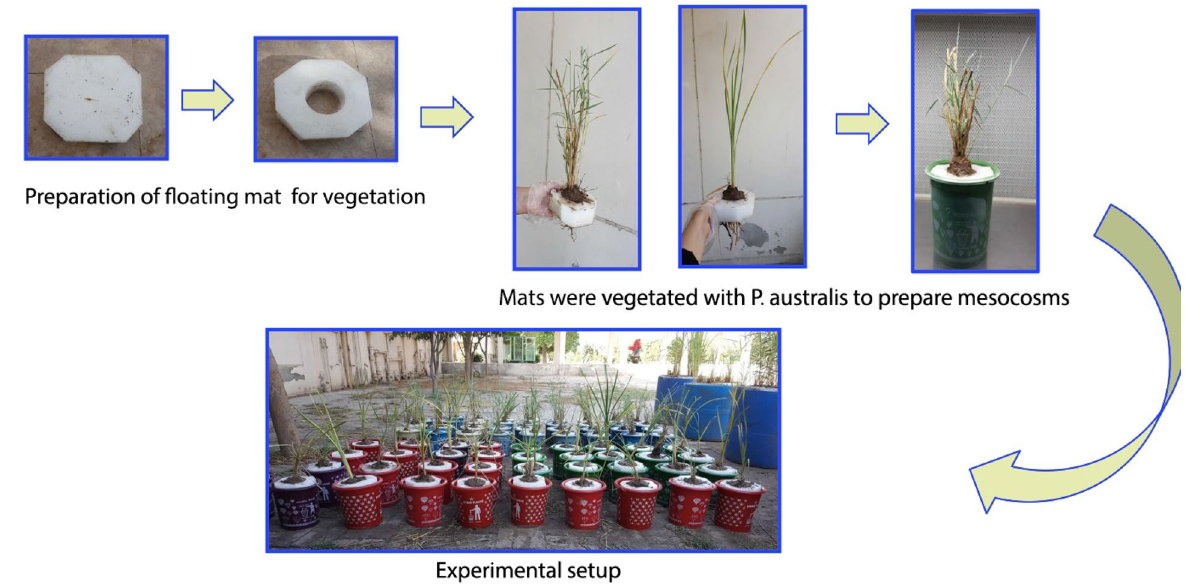
Figure 1. Preparation of mesocosms with P. australis for the optimization of FTW operational